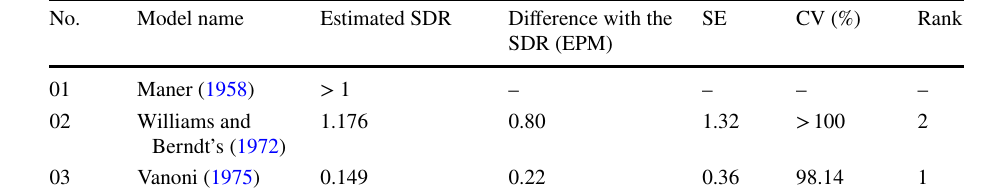
Table 6 Comparison of the results of the models evaluated against the basic SRR (0.27) and their ranks